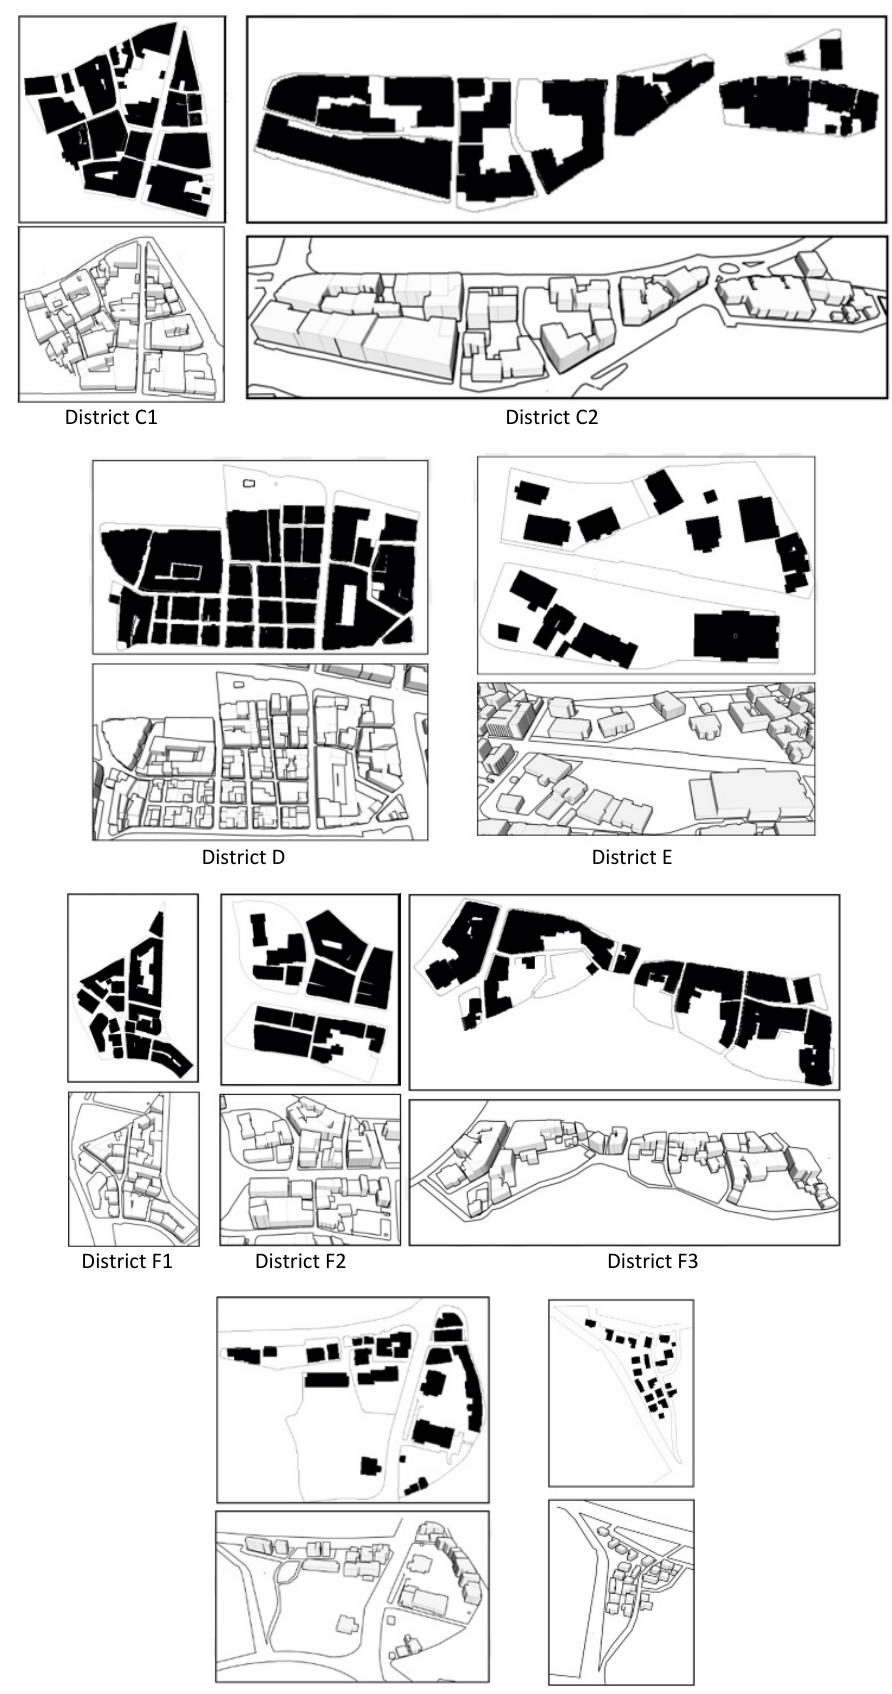
Figure 11 Figure-ground analyses of sub-districts with morphologically different characteristics (Ünal,